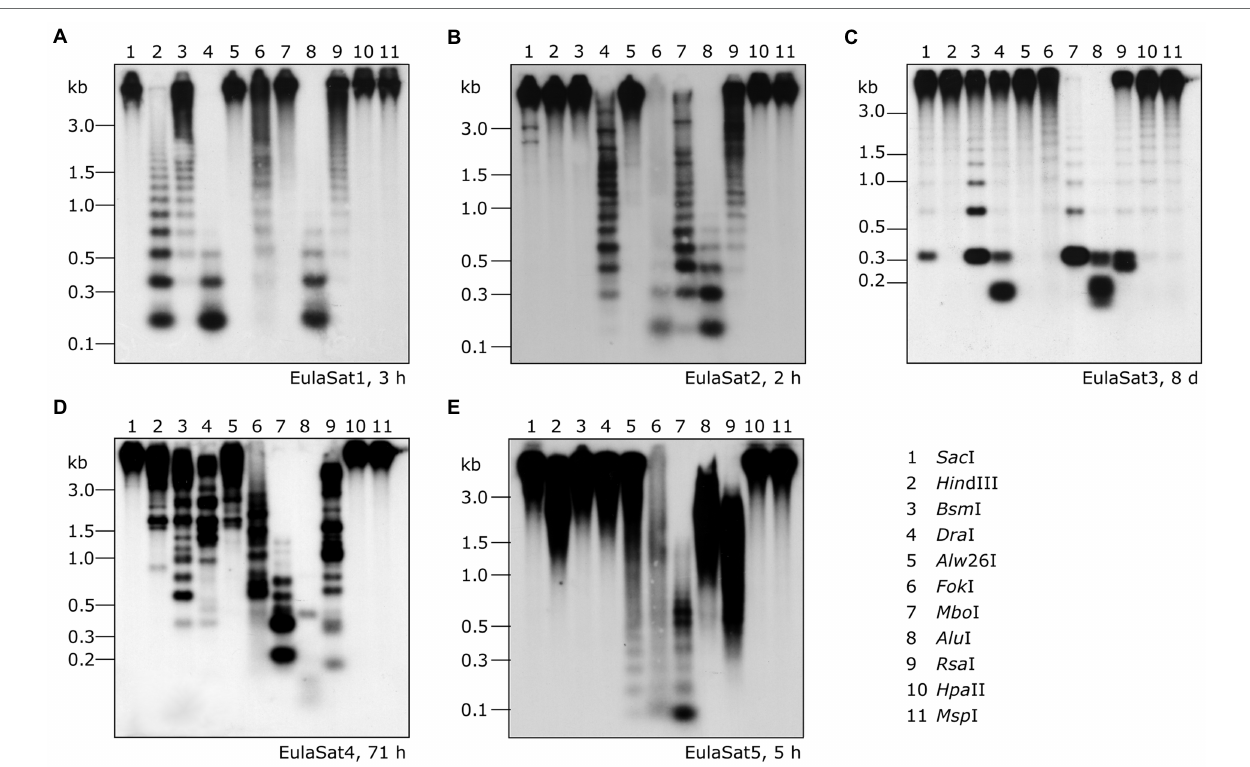
FIGURE 3 | Genomic organization of the Larix satDNA families EulaSat1 to EulaSat5. Southern hybridization of restricted genomic L. decidua DNA with satDNA probes releases the satellite-typical ladder pattern of EulaSat1 (A) , EulaSat2 (B) , and EulaSat3 (C) , EulaSat4 (D) , and EulaSat5 (E) . The exposition time is indicated in hours (h) or days (d) for each experiment.